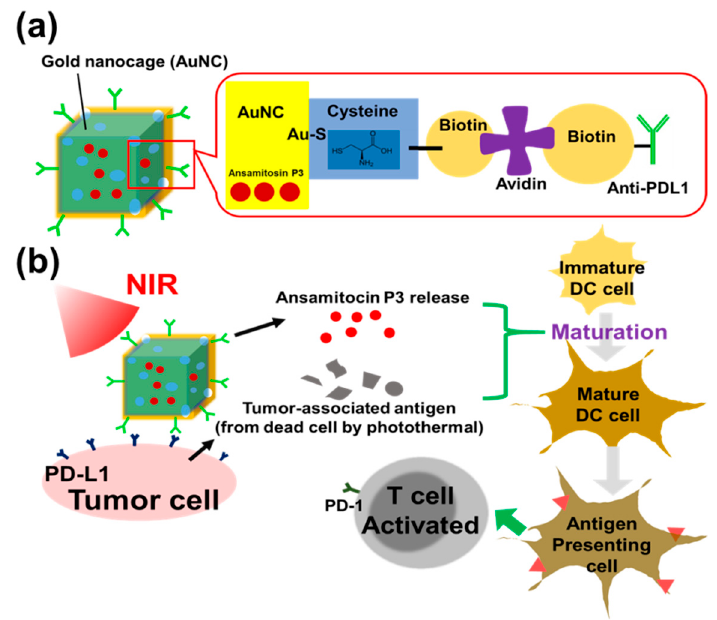
Scheme 1. Schematic illustration of ( a ) component of multifunctional AuNCs-based immunanoparticle and ( b ) the synergistic mechanisms of both photo-chemotherapy and photo-thermal therapy to mature DCs under NIR irradiation.